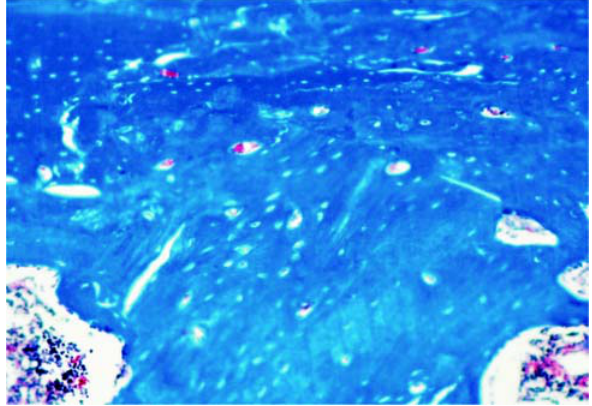
FIGURE 3- Group CC30: Higher amount of newly formed bone closing the surgical site margins and decreasing as closer it got to the defect central area. Masson’s Trichrome